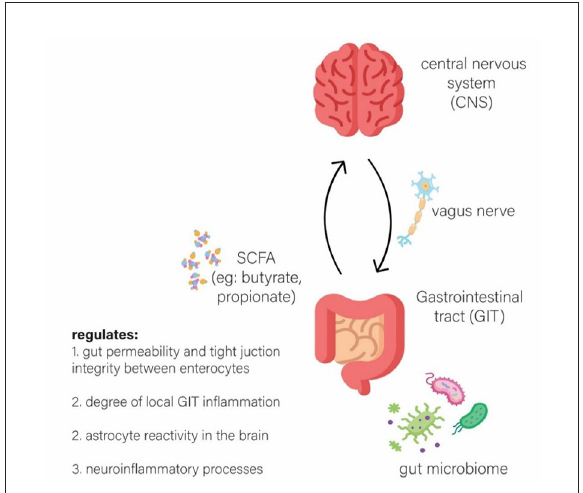
FIGURE1 The bi-directional communication between the Microbiota, Gut and Brain (brain-gut